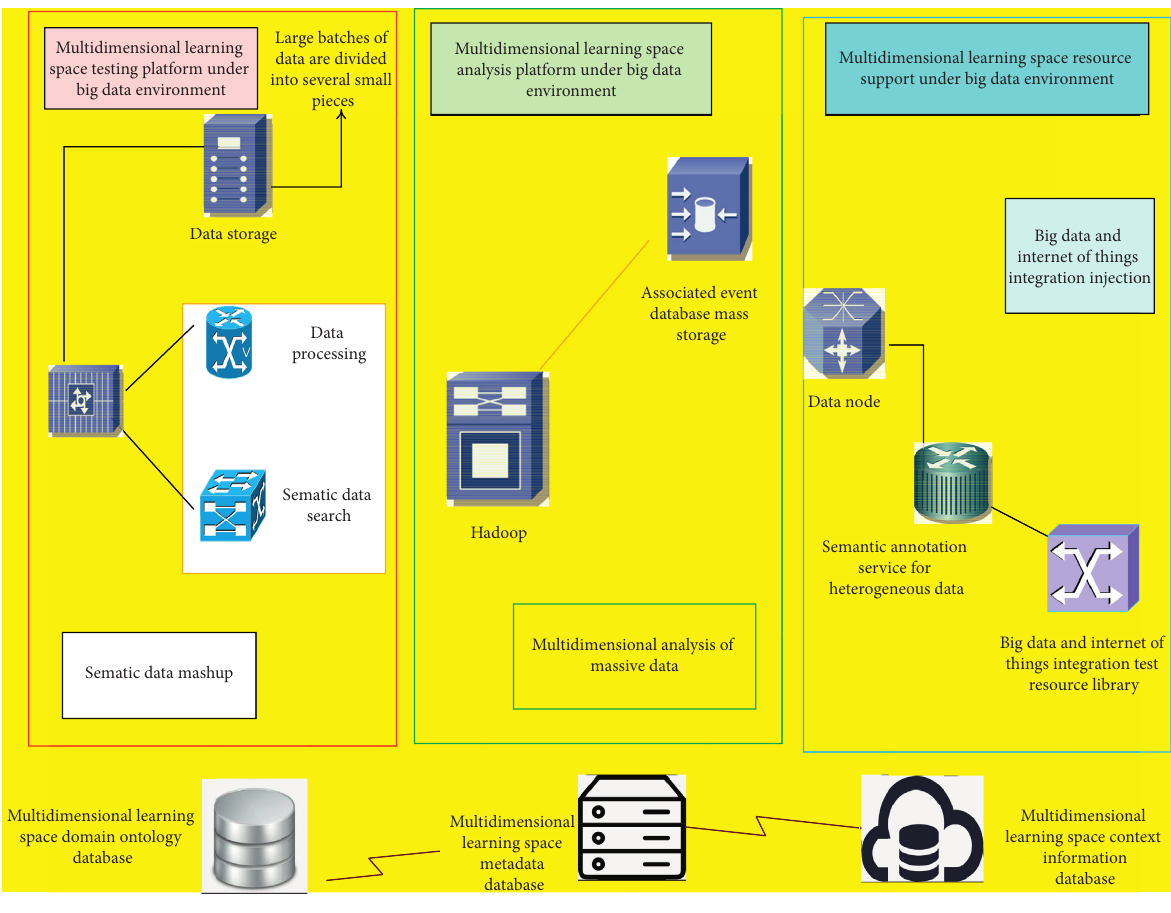
Figure 1: Big data batch processing model.